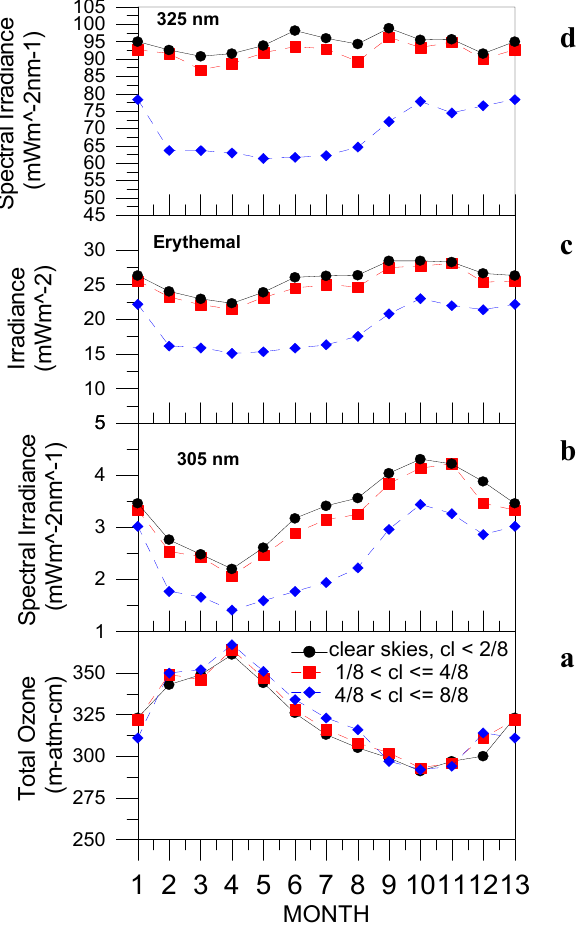
Fig. 1. The annual cycle of (a) total ozone, (b) solar spectral irradi- ance at 305 nm, (c) erythemal irradiance, and (d) solar irradiance at 325 nm under different sky conditions at 63 ◦ SZA as derived from measurements performed at Thessaloniki between November 1990 and November 1997.